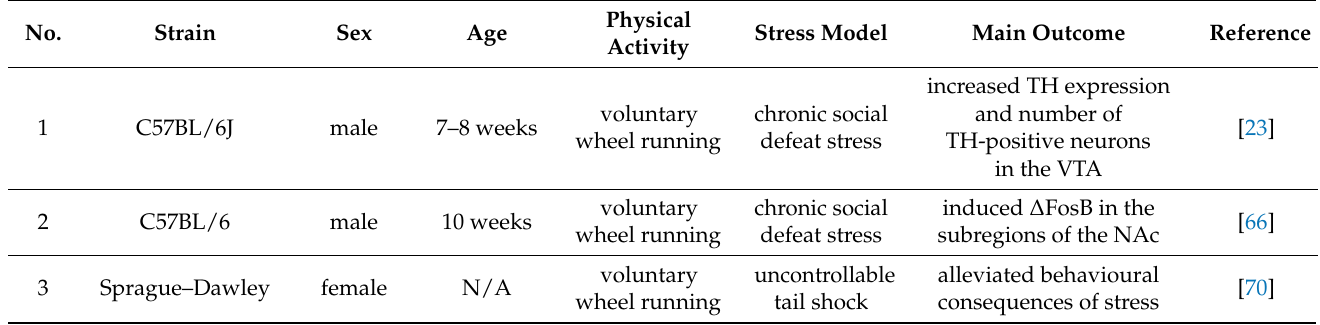
Table 2. Summary of animal research focusing on neurotransmitter